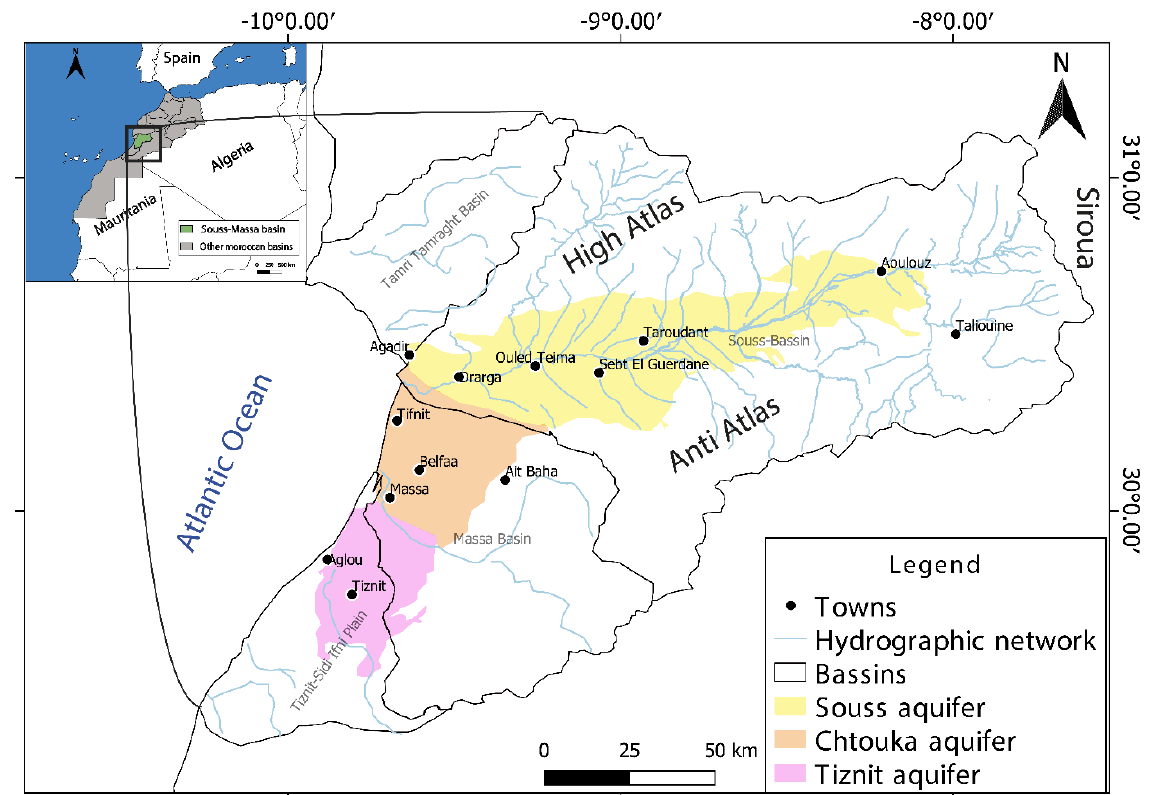
Figure 1. Localization of Souss-Massa basin.